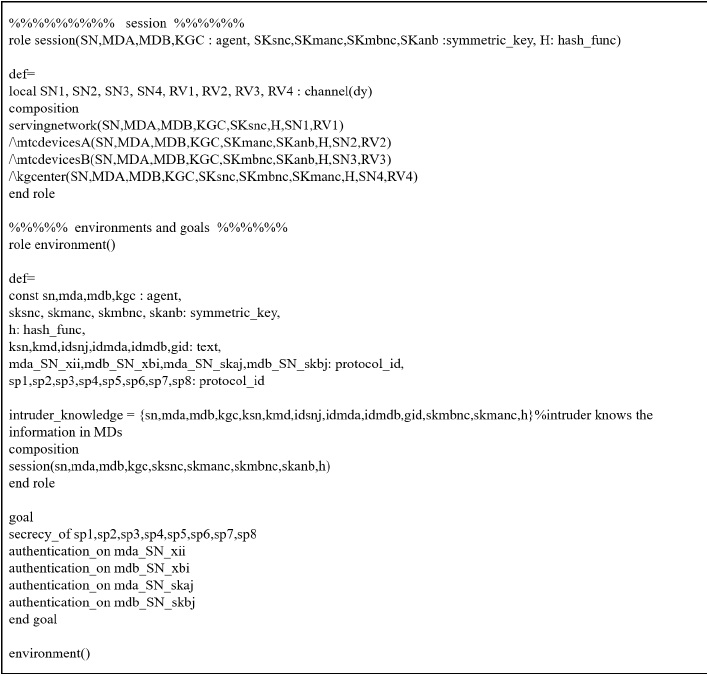
Figure 11. Scenario 2: HLPSL description of session and